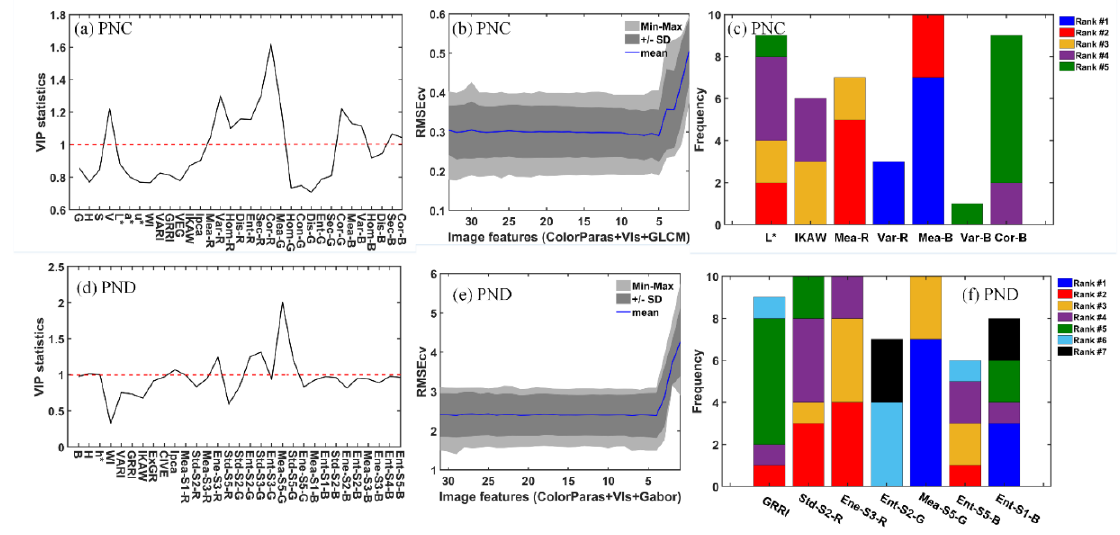
Figure 13. Determination of the influential image features in the winter wheat PNC and PND estimation based on the combination of textures, VIs, and color parameters: ( a , d ) The VIP values derived from the PLSR models; ( b , e ) the cross-validation RMSEcv statistics (mean, standard deviation, and min-max ranges) in the GPR-band analysis tool (BAT) procedure; ( c , f ) and the frequency plots of the selected image features in the cross-validation of GPR models.